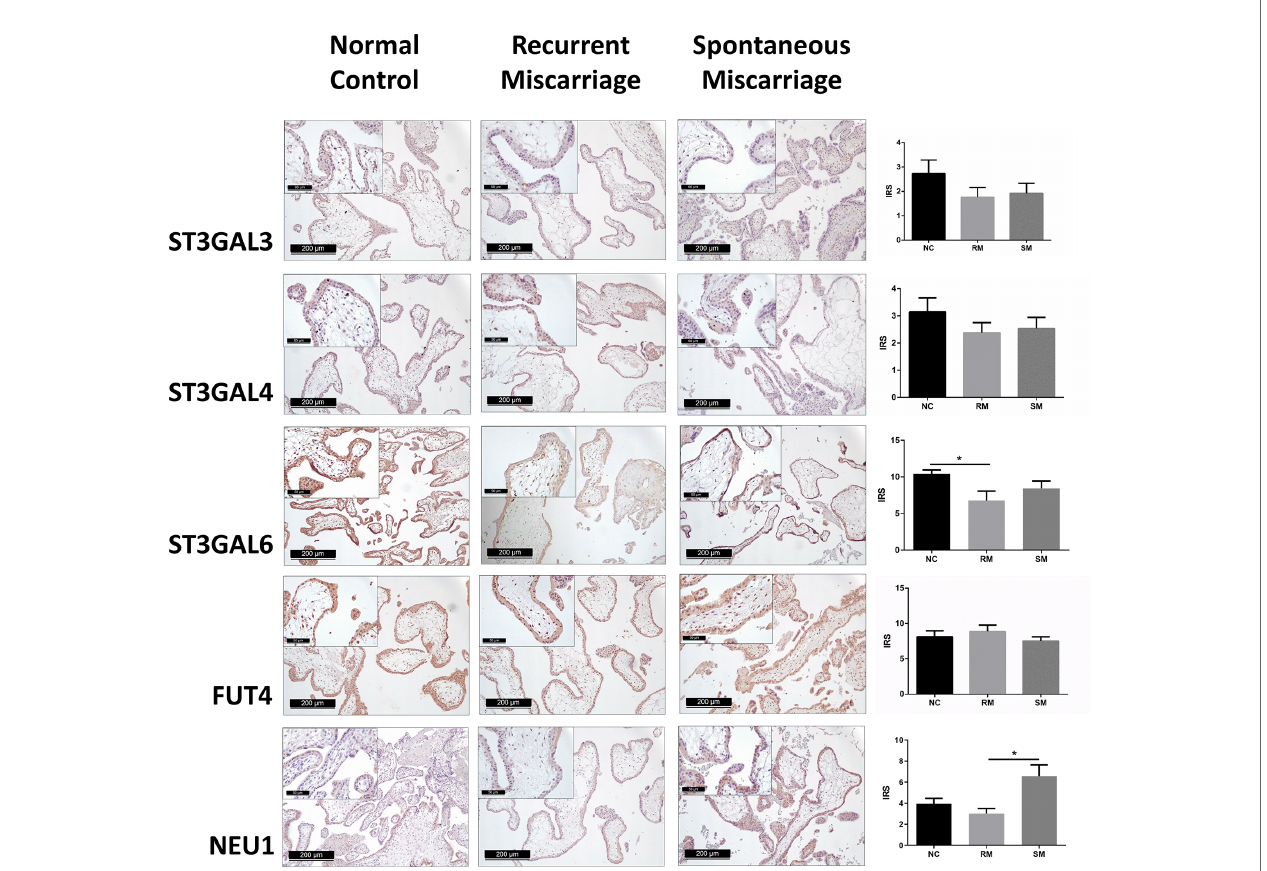
FIGURE 5 | Immunohistochemical staining of fi ve potential key enzymes that responsible for the synthesis of carbohydrate Lewis antigens in the syncytiotrophoblast of three groups of placenta tissues. *P < 0.05.